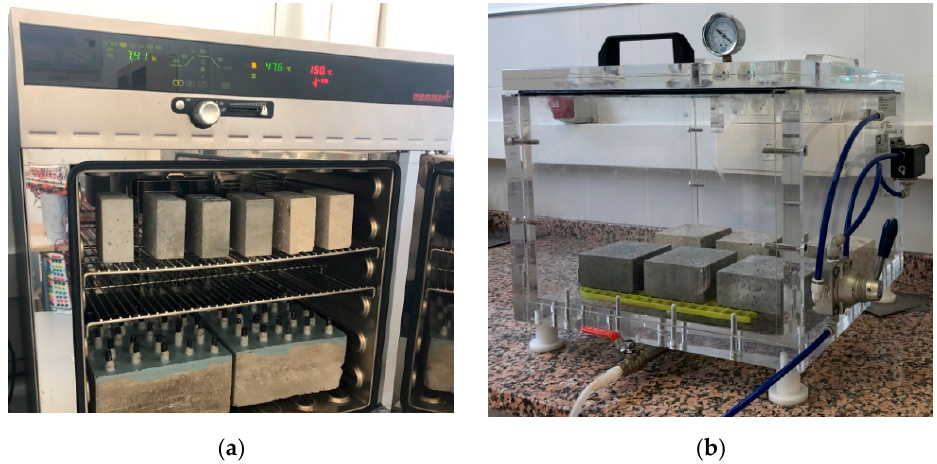
Figure 2. Water absorption set up: ( a ) specimens in the oven; ( b ) specimens in the vacuum chamber.